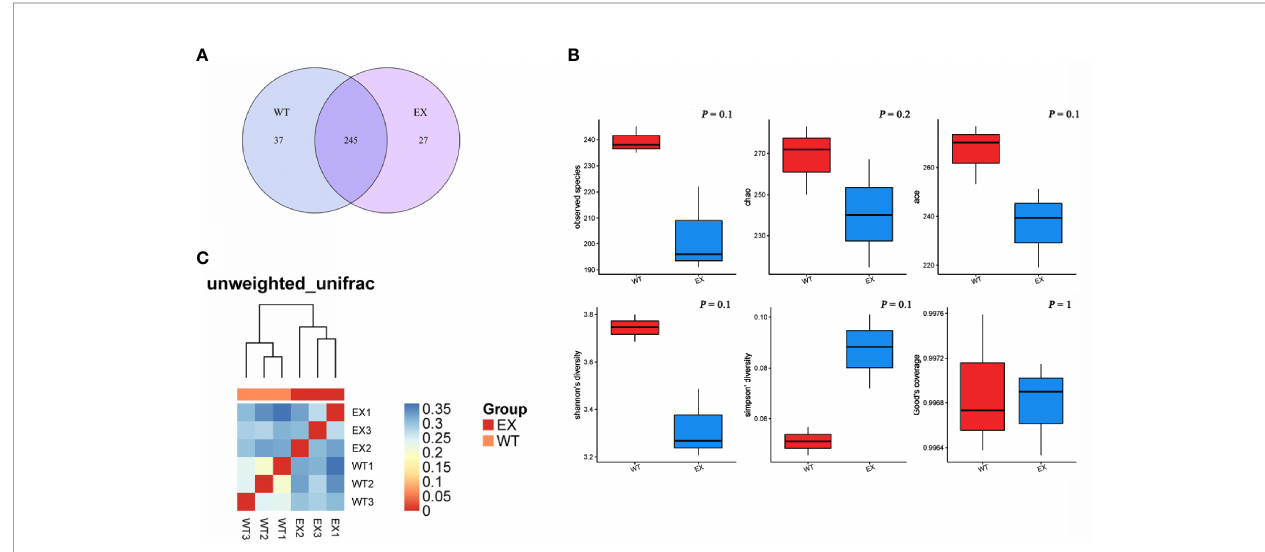
FIGURE 6 | The structural characteristics of the intestinal microbiome. (A) Venn diagram of two groups intestinal samples of BaX030-added or not based on OTU; (B) Diversity analysis of the intestinal microbiota in grass carp between healthy and diseased groups; (C) The heat map of Beta